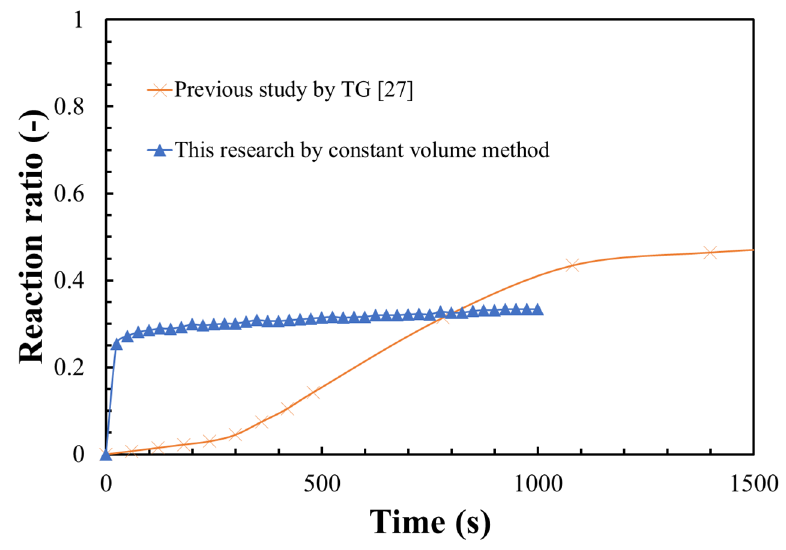
Figure 6. LiOH hydration reaction (temperature 47 °C, steam pressure 5 kPa, and particle size 100–125 μ m) with that by the thermal gravity method (TG) [27].